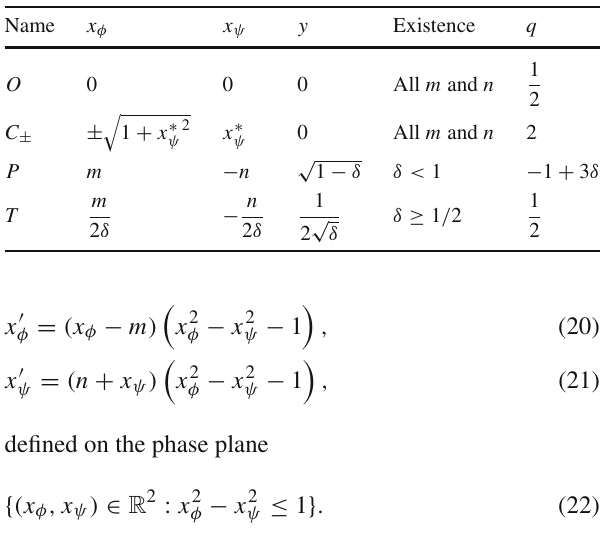
Table 4 Location, existence and deceleration factor of the equilibrium points for m > 0, n > 0 and y > 0 . We use the notation δ = m 2 − n 2 (from Ref. [31])